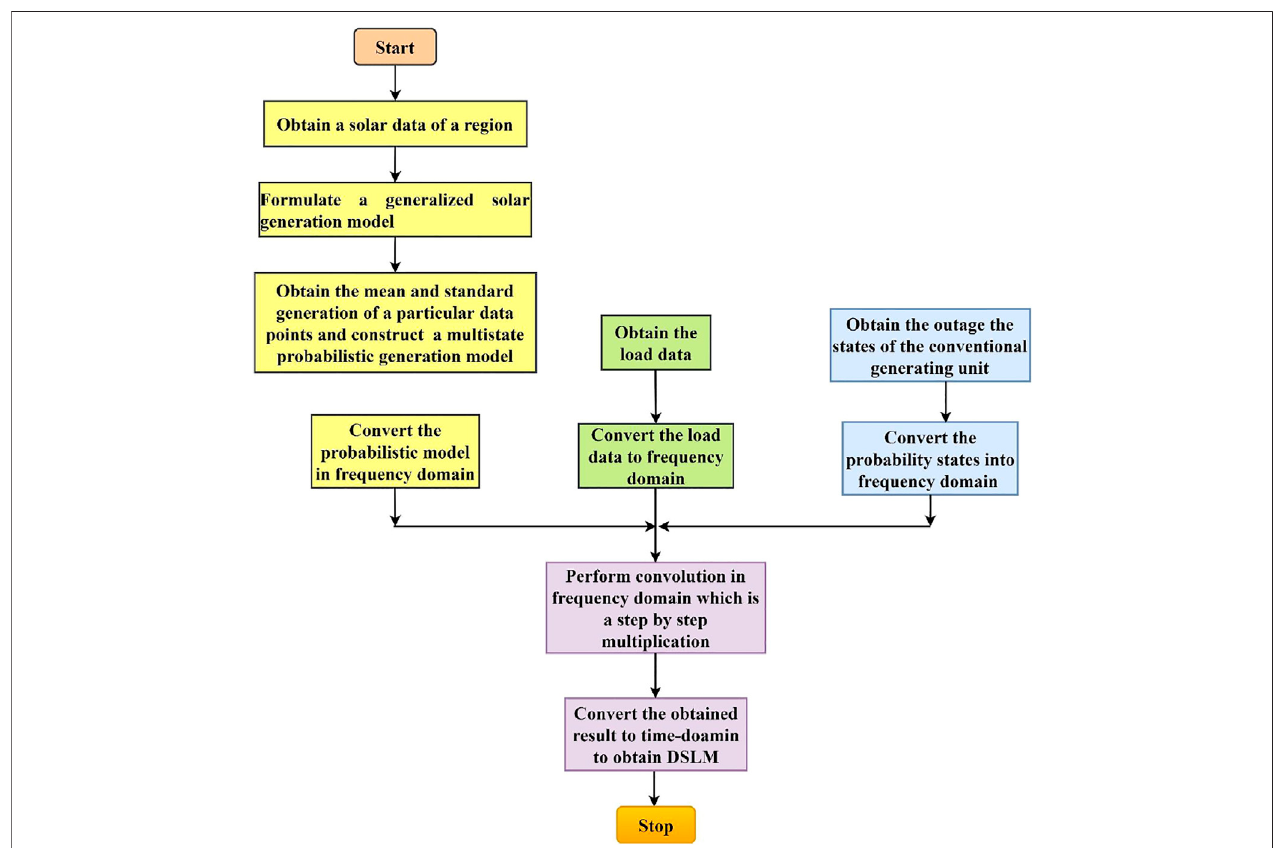
FIGURE 7 | Reliability evaluation process considering outage of generating units and intermittency of solar generation.